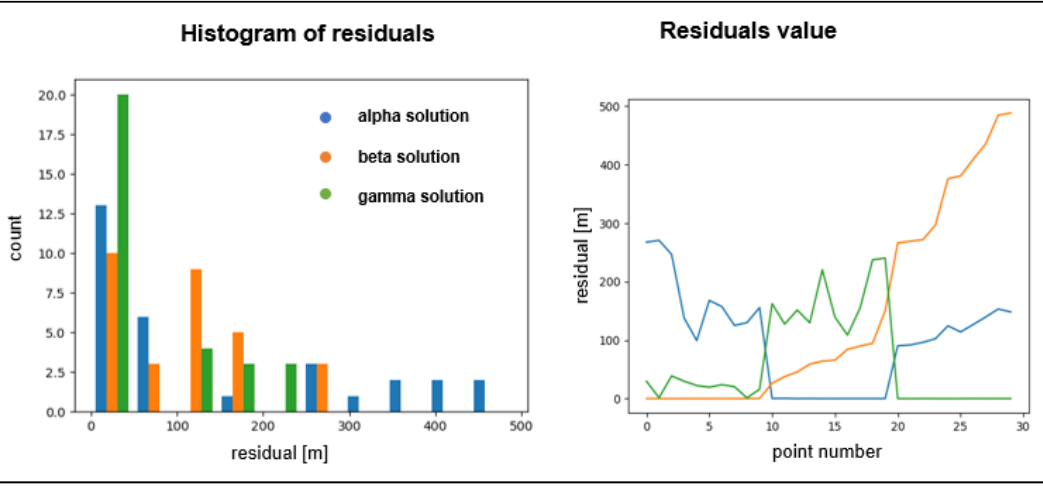
Figure 17. Test object histogram of residuals and residuals value.